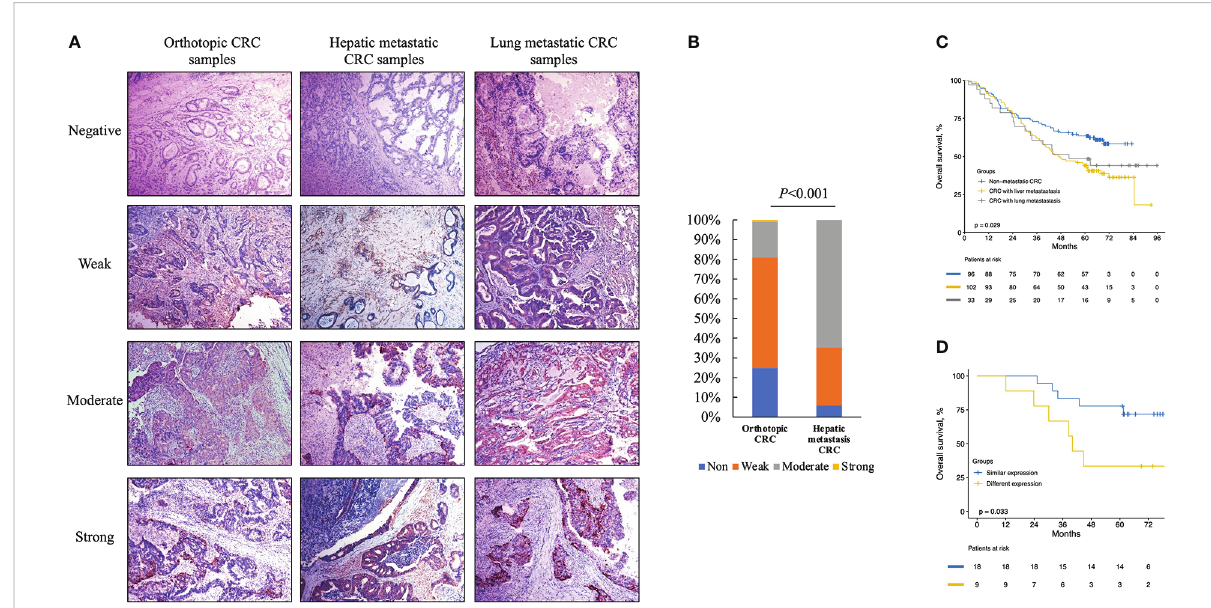
FIGURE 5 Immunohistochemistry (IHC) for cytoplasm apoB in representative orthotopic and metastatic tissues and the following statistical analysis. (A) IHC for cytoplasm apoB in orthotopic CRC, hepatic metastatic CRC and lung metastatic CRC. (B) the expression levels of apoB between orthotopic CRC and liver-metastatic specimens. (C) the survival analysis according to the non-metastatic CRC, liver-metastatic CRC, and lung- metastatic CRC in 231 patients. (D) the survival analysis according to different expression levels between orthotopic and metastatic group in 27 patients received colon-liver simultaneous resection. CRC, colorectal